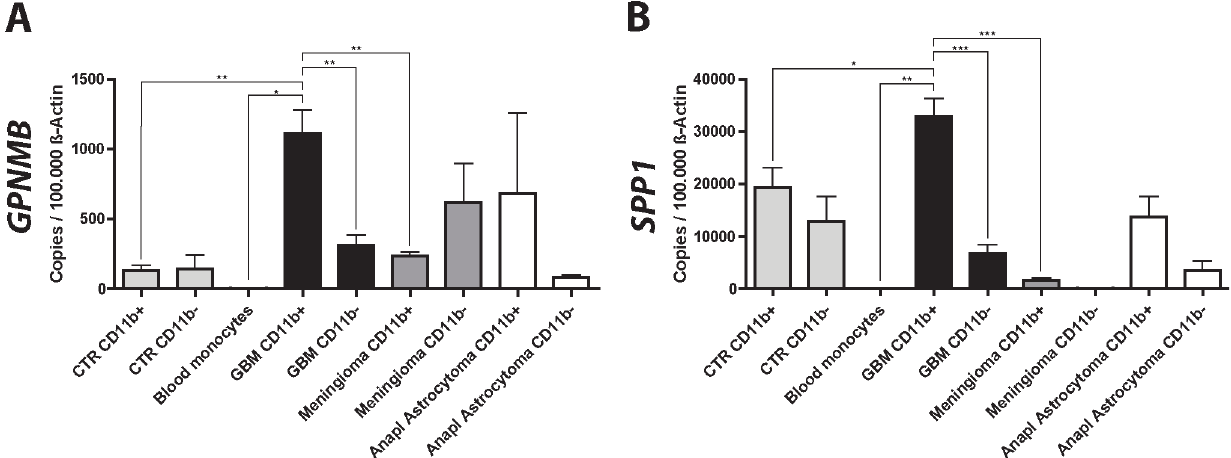
Fig 8. GPNMB and SPP1 expression is upregulated in human GAMs. We determined the expression of the genes GPNMB and SPP1 in CD11b + and CD11b - cells isolated from human GBM (CD11b + n = 15, CD11b - n = 9), meningioma (CD11b + n = 5, CD11b - n = 3), grade III anaplastic astrocytoma (CD11b + n = 2, CD11b - n = 2), control brain (CD11b + n = 5, CD11b - n = 2) and blood monocyte samples (n = 2). The expression of GPNMB and SPP1 was significantly higher in CD11b + cells isolated from GBMs compared to CD11b + cells isolated from control brain, benign meningioma samples, blood monocytes, and CD11b - cells in GBM. Bar graphs illustrate the absolute number of transcripts normalized to 100,000 transcripts of ACTB . Analysis was done by students t test. Error bars indicate the SEM. * , p < 0.05; ** , p < 0.01; *** , p <